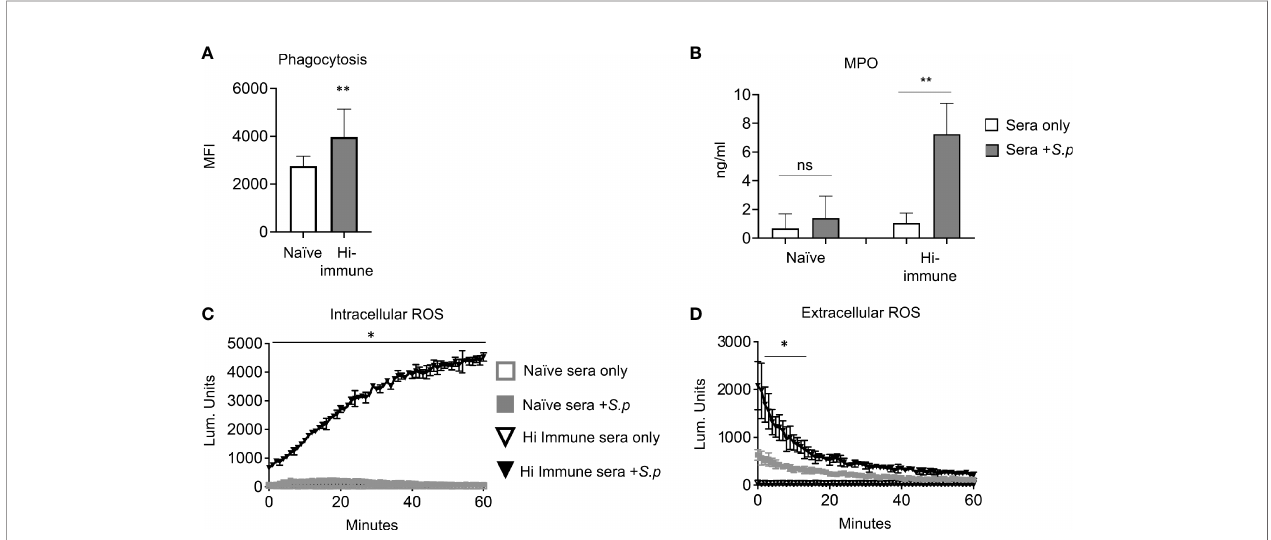
FIGURE 3 | PMN anti-bacterial responses are enhanced in the presence of speci fi c anti-pneumococcal antibodies. (A) PMNs were isolated from the bone marrow of young male C57BL/6 naïve mice and infected for 10 minutes with GFP tagged S. pneumoniae TIGR4 preopsonized with naïve or heat inactivated immune sera. The amount of GFP positive bacteria (MFI) inside each cell was determined via fl ow cytometry using inside-out staining. Data are pooled from three separate experiments where each condition was tested in triplicate (n = 3). Signi fi cant differences ( p < 0.05 , indicated by *) were determined by unpaired Student ’ s t test. (B – D) PMNs isolated from the bone marrow of young male C57BL/6 naïve mice were infected with S. pneumoniae pre-opsonized with naïve or heat inactivated (Hi-) immune sera or mock treated with sera alone as indicated. (B) The supernatants were collected and myeloperoxidase (MPO) levels measured by ELISA. *, denotes signi fi cant difference compared to uninfected controls as determined by unpaired Student ’ s t test. Data are pooled from 3 separate experiments with n = 3 mice per group. (C) Production of intracellular ROS over time was measured by chemiluminescence of luminol. (D) Production of extracellular ROS over time was measured by chemiluminescence of isoluminol in the presence of HRP. (C, D) Data are representative of one of three separate experiments where each condition was tested in triplicate (n = 3 technical replicates) per experiment. Signi fi cant differences ( p < 0.05 , indicated by *) were determined by 2-way ANOVA followed by Sidak ’ s multiple comparisons test. * denotes p < 0.05, and ** denotes p < 0.01